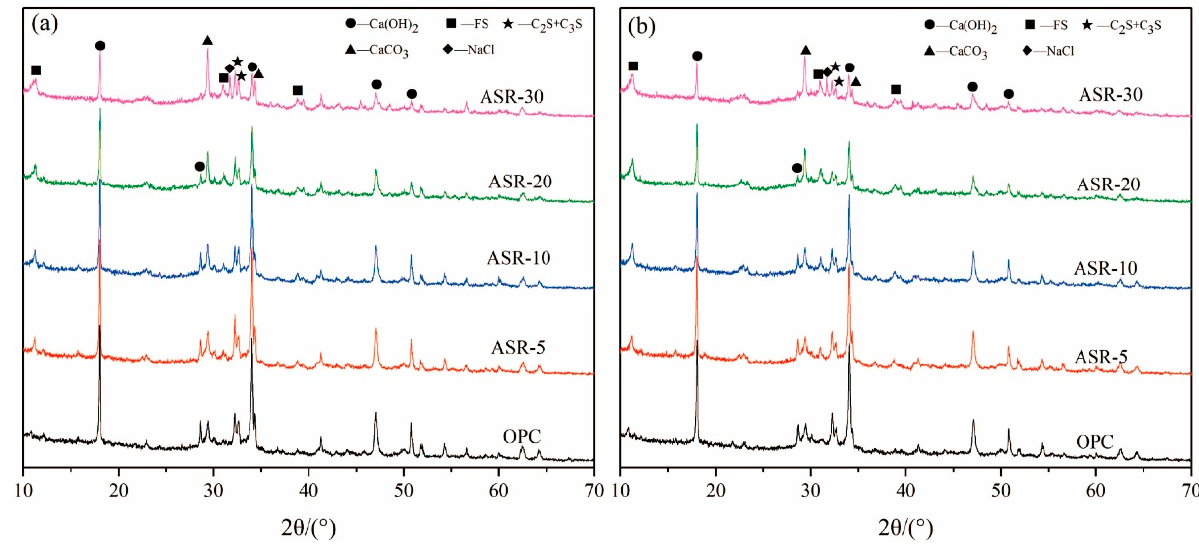
Figure 2. XRD patterns of ASR-cement composite cementitious materials: ( a ) 3 days; ( b ) 28 days.